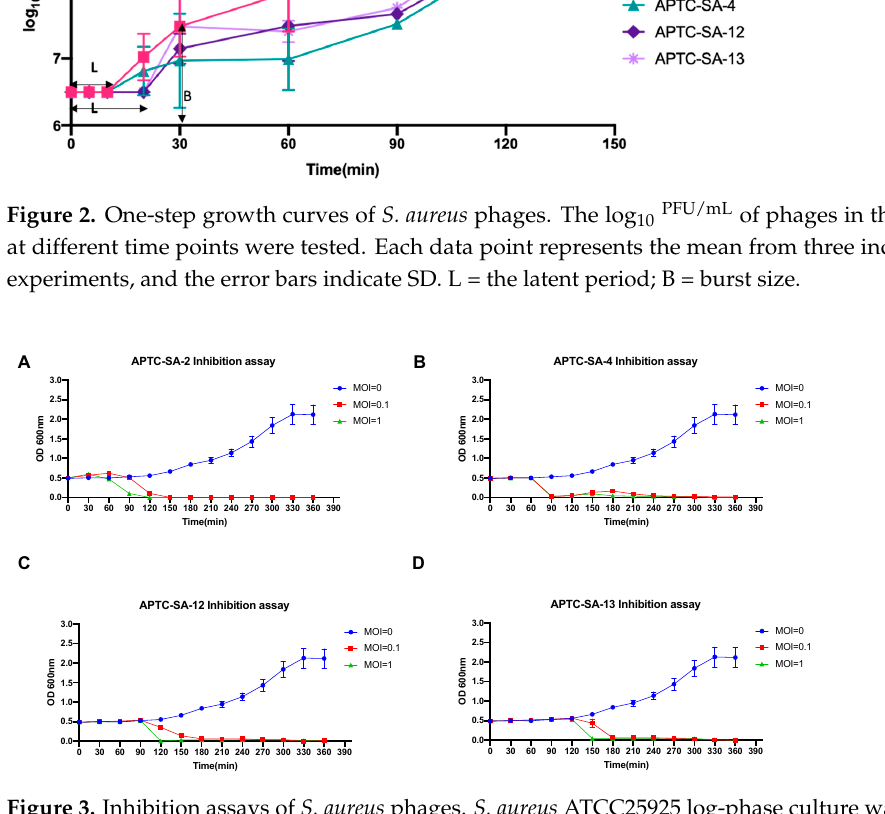
Figure 2. One-step growth curves of S. aureus phages. The log 10 PFU/mL of phages in the cultures at different time points were tested. Each data point represents the mean from three independent ex- periments, and the error bars indicate SD. L = the latent period; B = burst size.